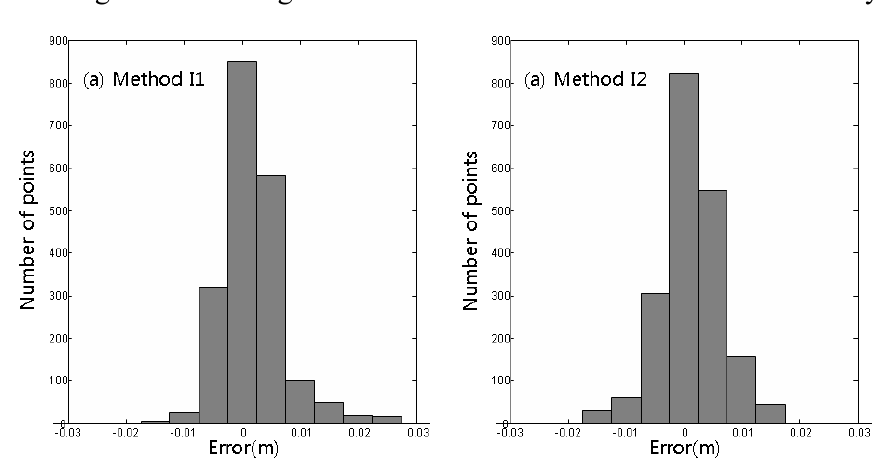
Figure 20. Histogram of the integrated RTK-GPS/accelerometer calculation error by